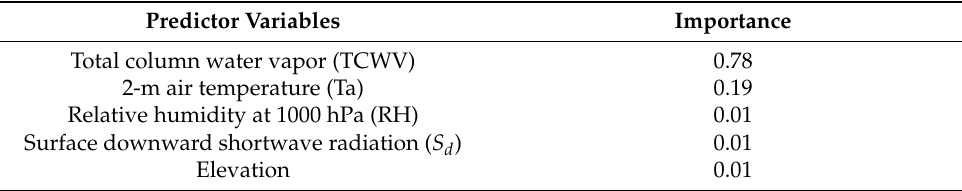
Table 2. Importance rankings of all predictor variables for L d estimation.